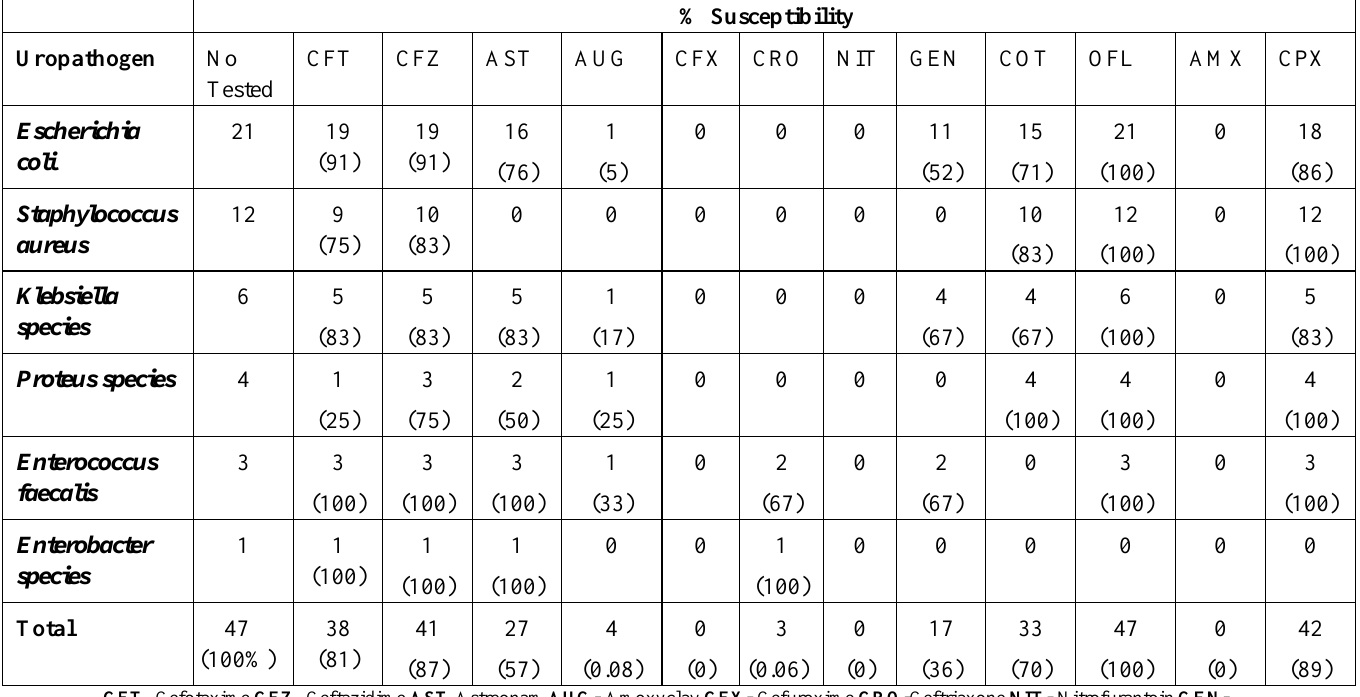
Table 4. Antimicrobial susceptibility pattern of bacteria from asymptomatic bacteriuria in